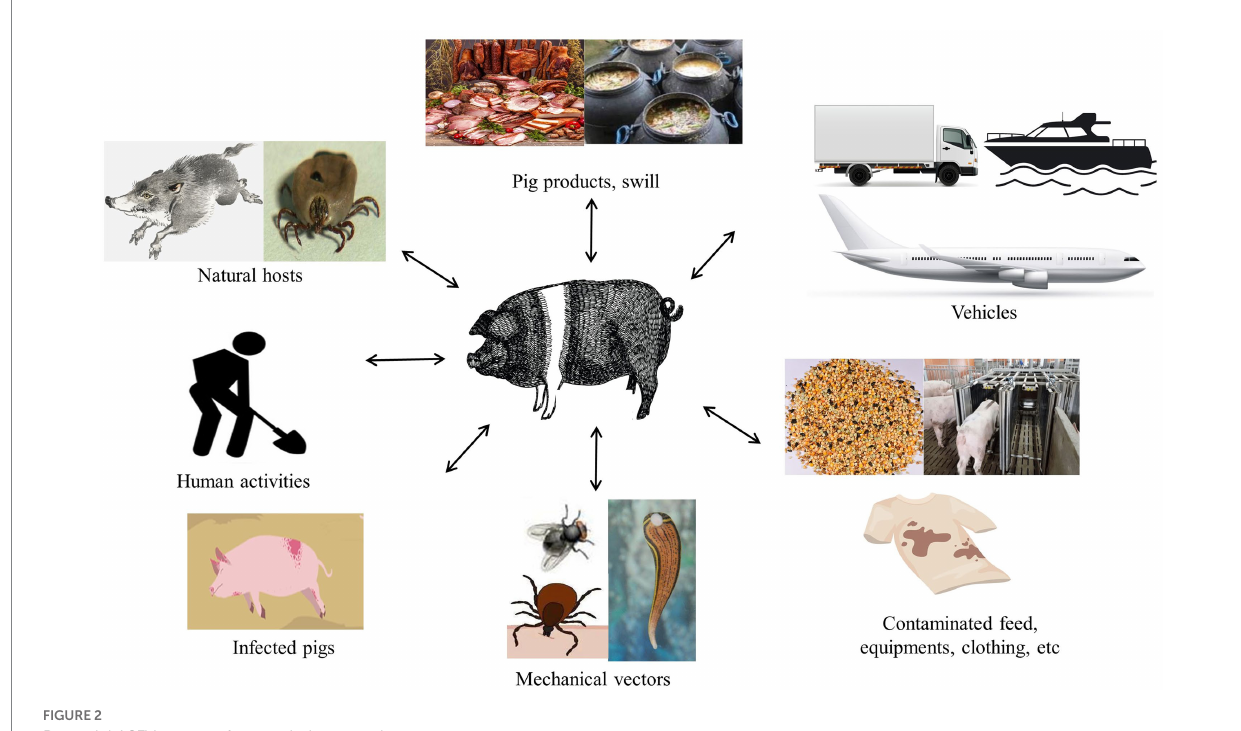
FIGURE 2 Potential ASFV routes of transmission to